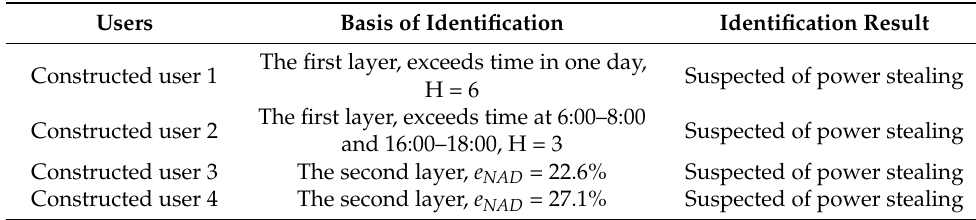
Table 4. Identification Results of Constructed Power-Stealing Users.